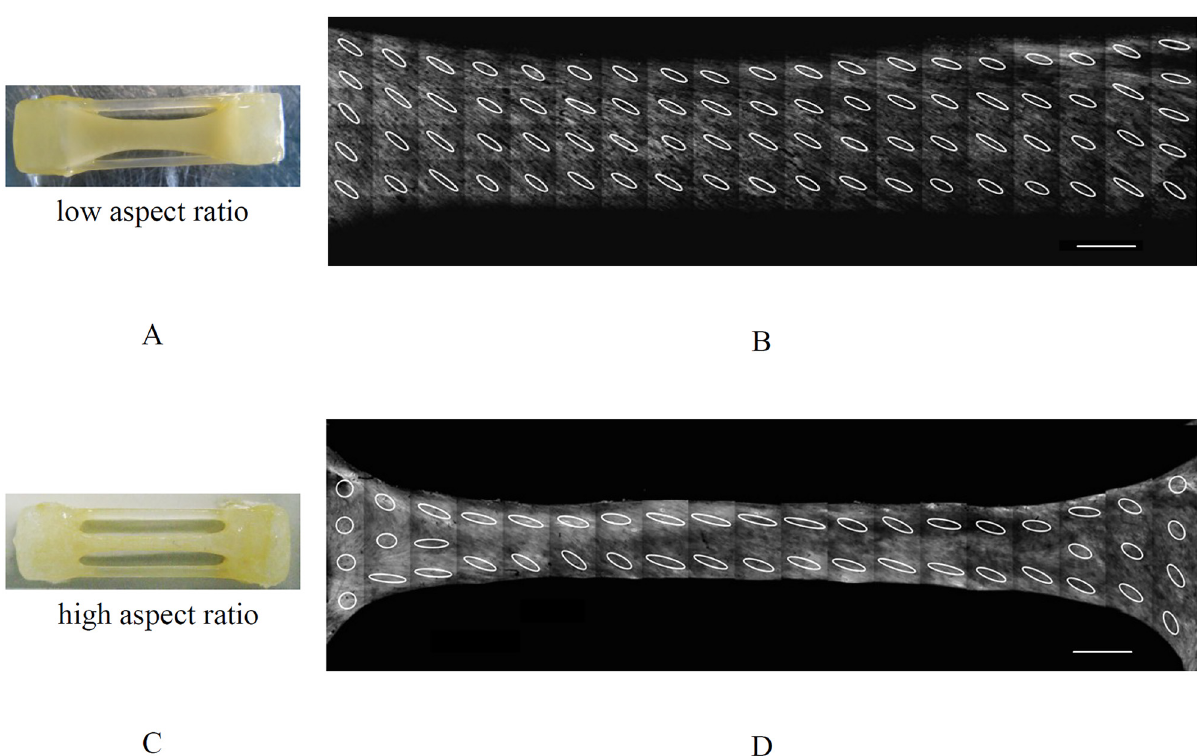
Fig 5. Macroscopic images of low (A) and high (C) ratio rectangular TE strips cultured for 3 weeks and corresponding CLSM images of collagen fibers (B, D). The scale of alignment is shown by ellipses for each tile. Collagen fibers aligned in the oblique direction in low aspect ratio strips after 3 weeks, while they were aligned in the constrained direction in high aspect ratio strips. Scale bars represent 1 mm.